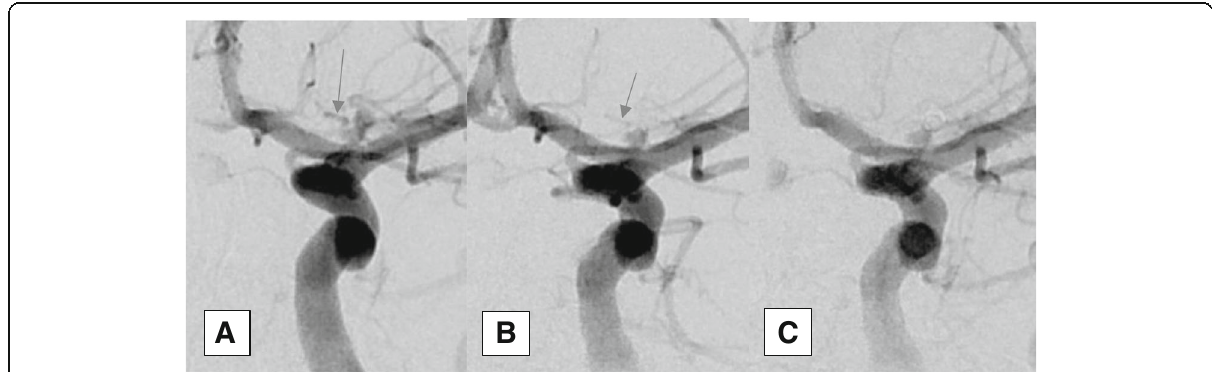
Fig. 2 Carotid terminus aneurysm before ( a ) and after coiling ( b ) and ( c ) showing residual neck (class II) according to modified Raymond – Roy Classification. The aneurysmal neck was left intentionally for preservation of small branch that was seen arising from it